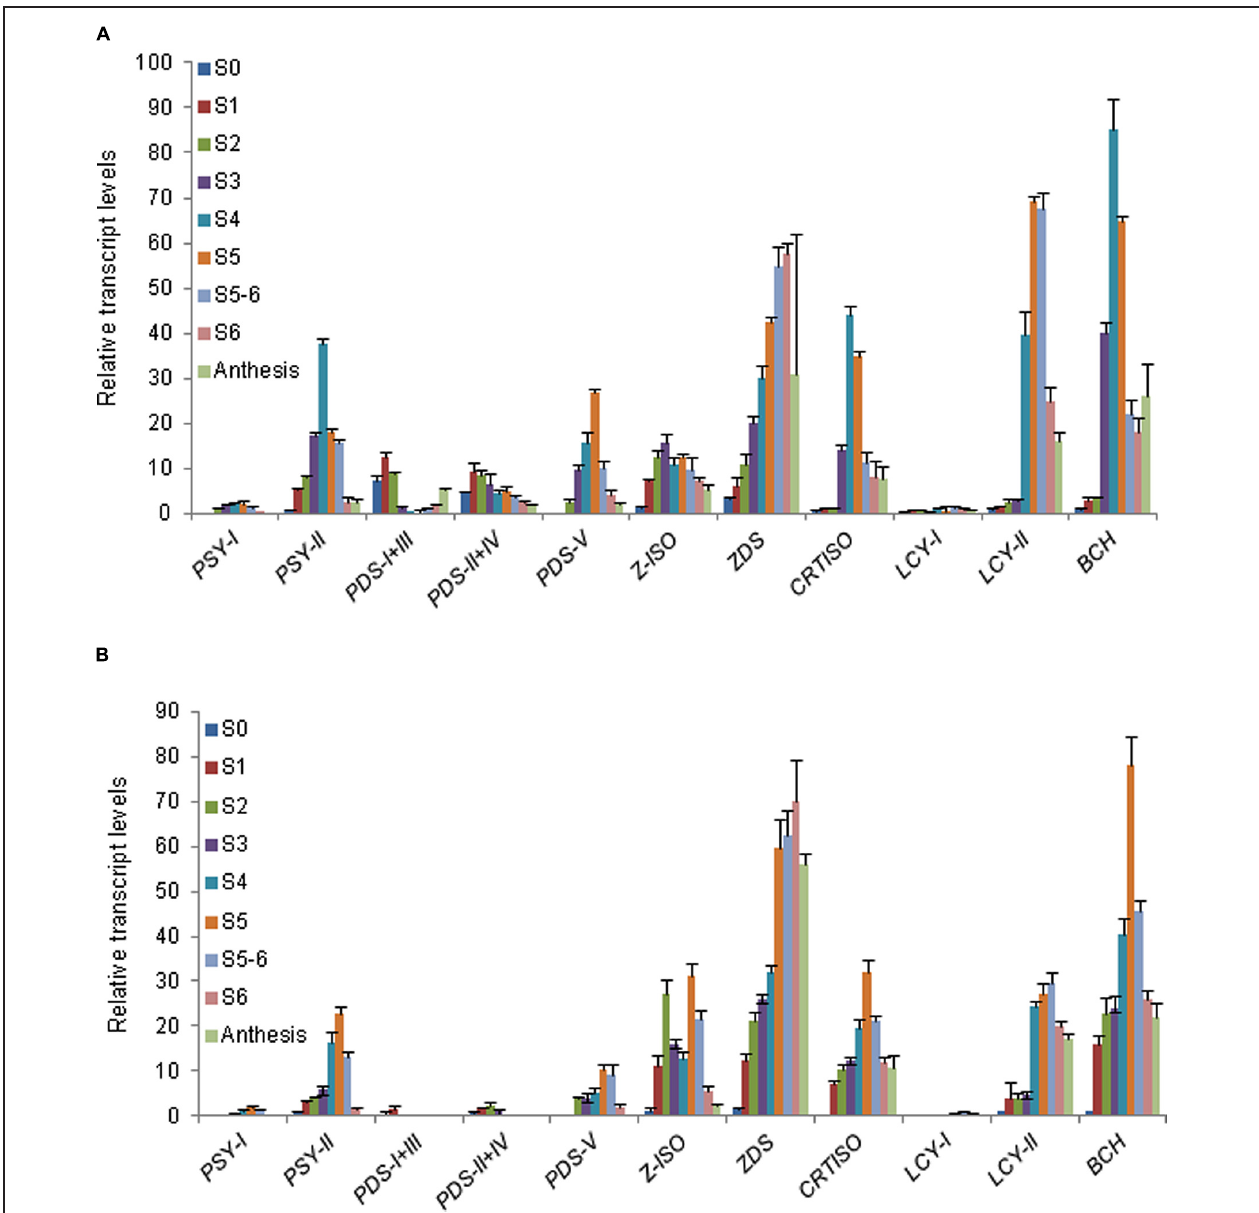
FIGURE 4 | Analysis of carotenogenic genes expression during stigma and tepal development in flowers of C. ancyrensis . (A) Relative expression levels in nine developmental stages of stigma. (B) Relative expression levels in nine developmental stages of tepals. Values are means of three technical replicates ± SE, normalized to the internal control